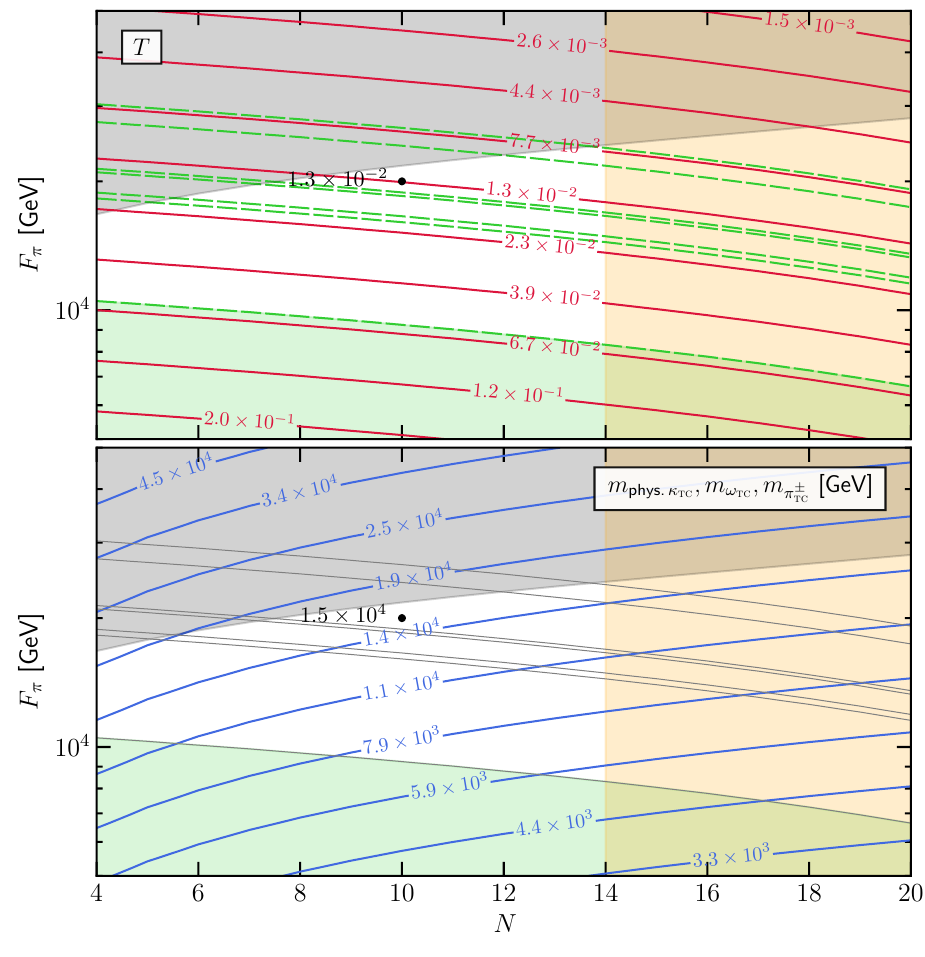
Figure 3 . Numerical results for T and m phys. (cid:20) tc (cid:25) m ! (cid:25) m (cid:25) (cid:6) tc , as a function of N and F (cid:25) , with c m = c t = 1, N c = 3, (cid:3) low = 8 : 5 MeV, f = 10 11 GeV, (cid:13) i = 10 10 , and (cid:11) e ( m Z ) 1 = 127 : 950(17) [82] (cid:25) (cid:12)xed, and with y t ; h ; and (cid:15) t adjusted to obtain G F = 1 : 1663787(6) 10 (cid:0) 5 GeV (cid:0) 2 [82], h i (cid:2) m t = 173 : 21(51)(71) GeV [82], and m phys. Higgs = 125 : 09(24) GeV [82]. The dashed (green) lines in the left panel are the one-parameter 95%-con(cid:12)dence exclusion regions on the T parameter (taken at (cid:12)xed S = U = 0 and computed using the results in table 1 of ref. [127] 27 ), for a variety of current and future colliders: from bottom to top, these lines represent the ‘Current’, ‘CEPC \Baseline"’, ‘ILC’, ‘FCC-ee-Z’, ‘CEPC \Improved (cid:0) Z ; sin 2 (cid:18) "’, ‘CEPC \Improved (cid:0) Z ; sin 2 (cid:18); m t "’, and ‘FCC- ee-t’ projections of ref. [79]. These same contours are indicated by light (grey) lines on the right panel. The green shaded region on each panel is excluded by the current T -parameter constraints. The grey shaded region in each panel is where the consistency relation eq. (7.13) is not satis(cid:12)ed. The orange shaded region indicates N > 14, where Landau poles in g 1 or g 2 may appear below the Planck scale (see section 3.1). Also shown on each panel (black dots) is the parameter point N = 10 and F (cid:25) = 20 TeV, along with the value of the respective quantity at that point; this parameter point is singled out for discussion in the